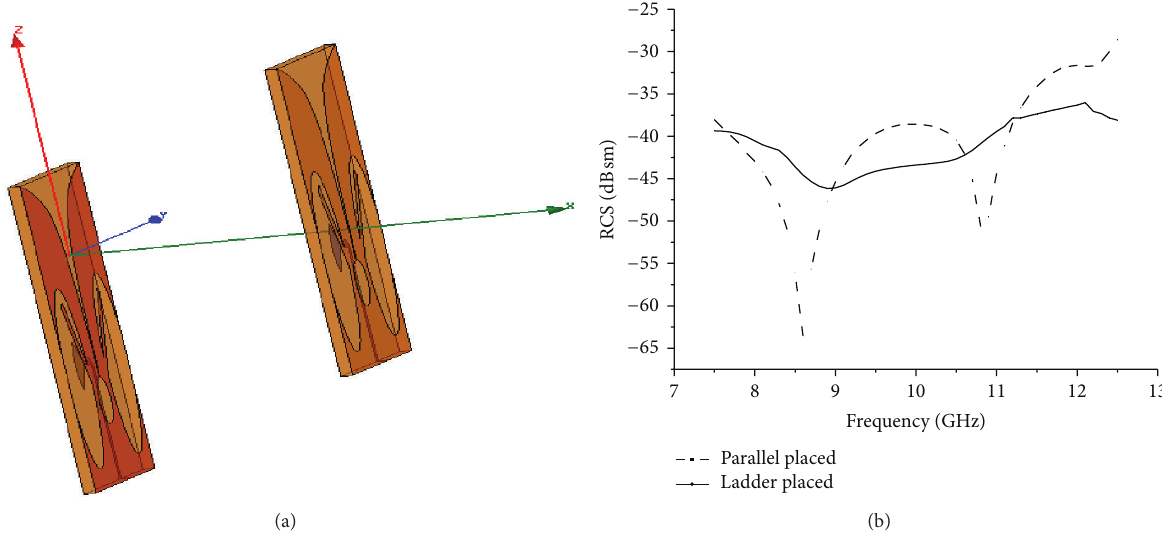
Figure 3: (a) Two-element ladder arranged array and (b) RCS of two-element array.